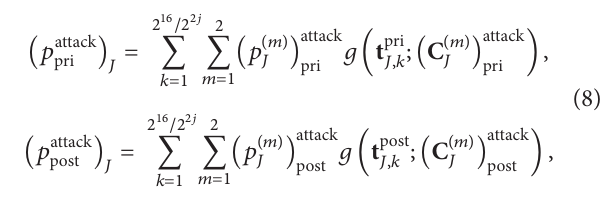
Table 1: Mean and standard deviation (Std.) of watermarked images by different algorithms